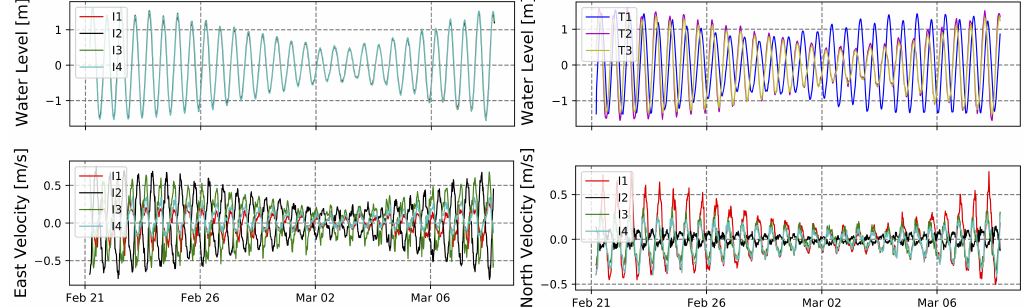
Figure 3. Water levels and East and North velocities measured during the field survey with the current meters (I1–I4) and water levels measured with the tidal gauges